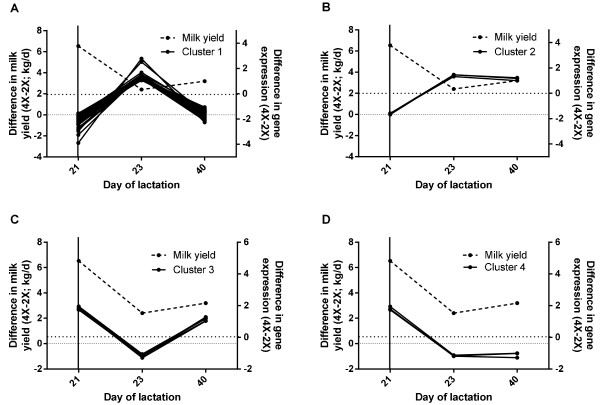
Temporal pattern of differential gene expression is associated with changes in milk yield. Cows were assigned to unilateral frequent milking (UFM; twice daily milking (2×) of the left udder half, four times daily milking (4×) of the right udder half) during d 1 to 21 of lactation. Mammary biopsies were obtained from both udder halves on d 21, 23, and 40 of lactation. Gene expression was detected using Affymetrix GeneChip® Bovine Genome Arrays. Genes of which differential expression changed over time were grouped into 4 clusters based on the temporal pattern of differential expression. Cluster 1 (panel A; 61genes) included genes whose expression in 4× vs 2× udder halves was lower on day 21, higher on day 23 (after cessation of 4× milking), and subsequently lower on day 40 of lactation. Cluster 2 (panel B; 3 genes) included genes whose expression in 4× vs. 2× udder halves was lower on day 21, higher on day 23, and remained higher on day 40 of lactation. Cluster 3 (panel C; 8 genes) included genes whose expression in 4× vs. 2× udder halves was higher on day 21, lower on day 23, and higher on day 40. Finally, cluster 4 (panel D; 3 genes) included genes whose expression in 4× vs. 2× udder halves was higher on day 21, lower on day 23, and remained lower on day 40. Differential milk yield is plotted on the left Y-axis and differential expression of genes in each cluster is plotted on the right Y-axis. Gene expression data are presented as signed fold change (4× minus 2×) for each gene. Solid vertical line represents cessation of UFM and return of all 4 glands to 2× milking on day 21 of lactation.